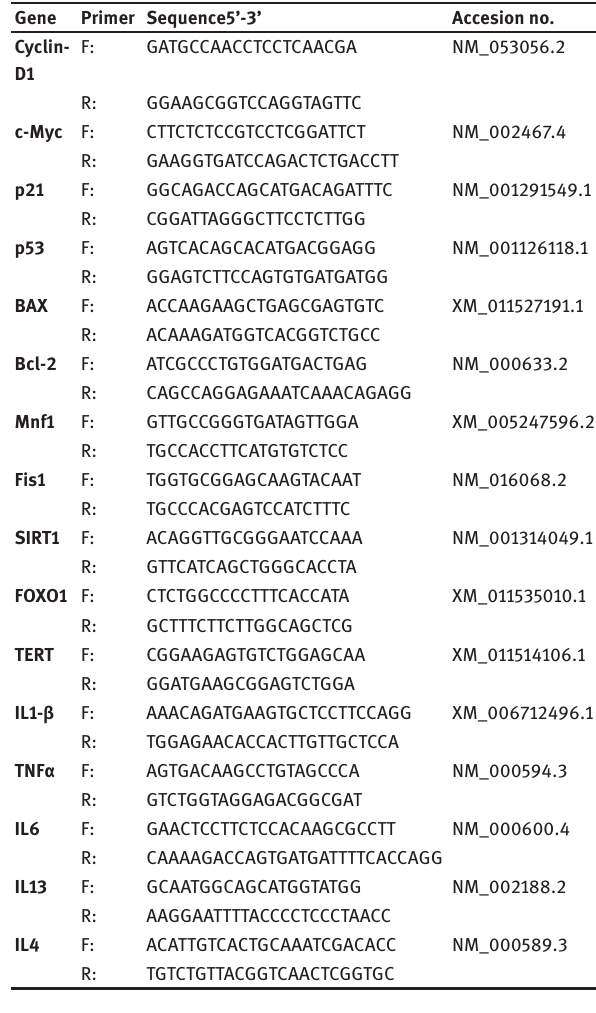
Table 1: Sequence of primers used in qRT-PCR. Gene Primer Sequence5’-3’ Accesion no.